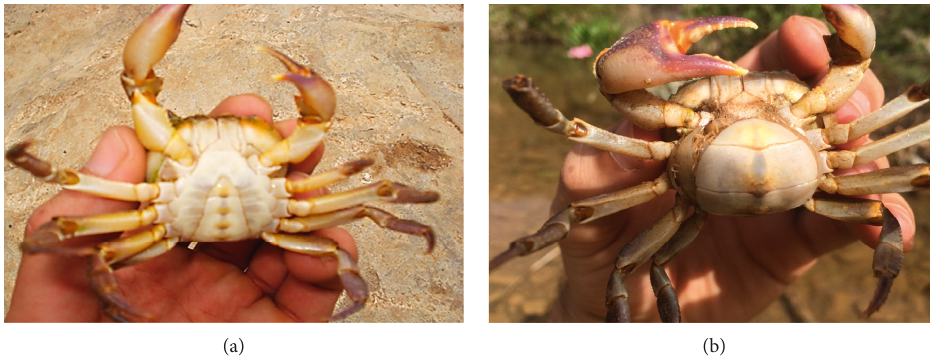
Figure 4: Abdomen morphology of the Potamon algeriense : (a) male abdomen and (b) female abdomen.